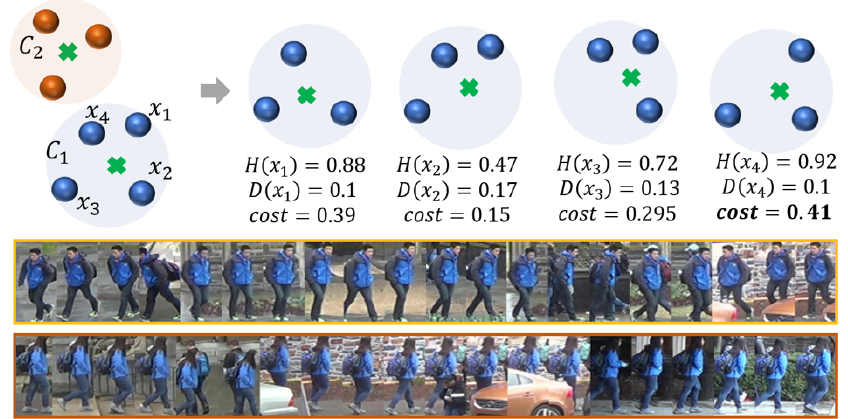
Figure 3. Gallery optimization. Upper area: example simplified where C 1 exceeds the memory budget and the gallery optimization selects the feature with the maximum cost to be dropped, x 4 . Lower area: visual sample of two appearance models from similar identities that are correctly separated in the DukeMTMC-VideoReID dataset. The yellow edge corresponds to identity 86 and the orange edge to identity 194, both ground truth